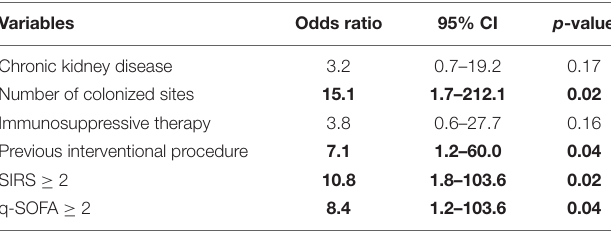
TABLE 3 | Stepwise logistic regression between Group 1 vs. Group 2 and between Group 1 vs. Group 3.